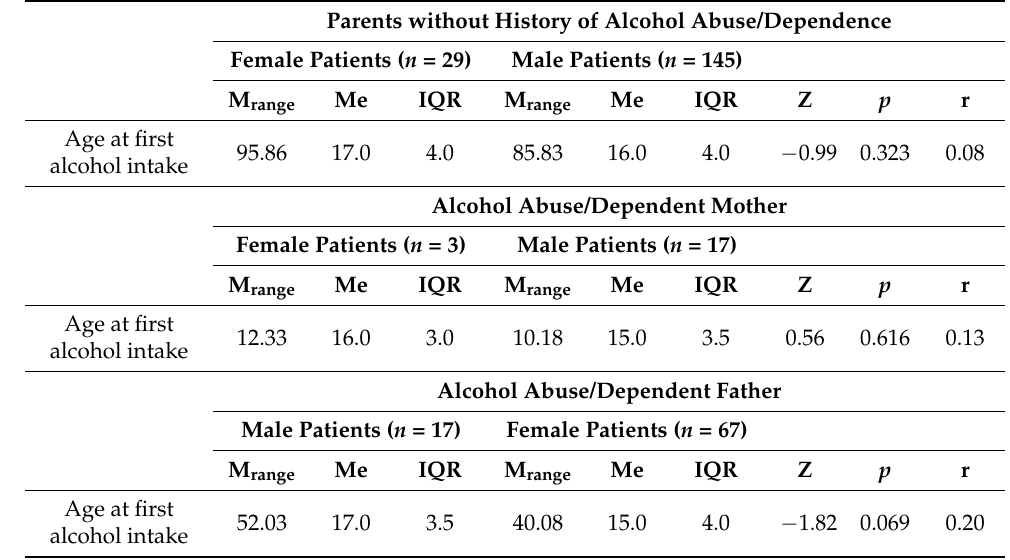
Table 2. Age at first alcohol intake and history of parental alcohol abuse/dependence by male and female patients with alcohol dependence ( n =